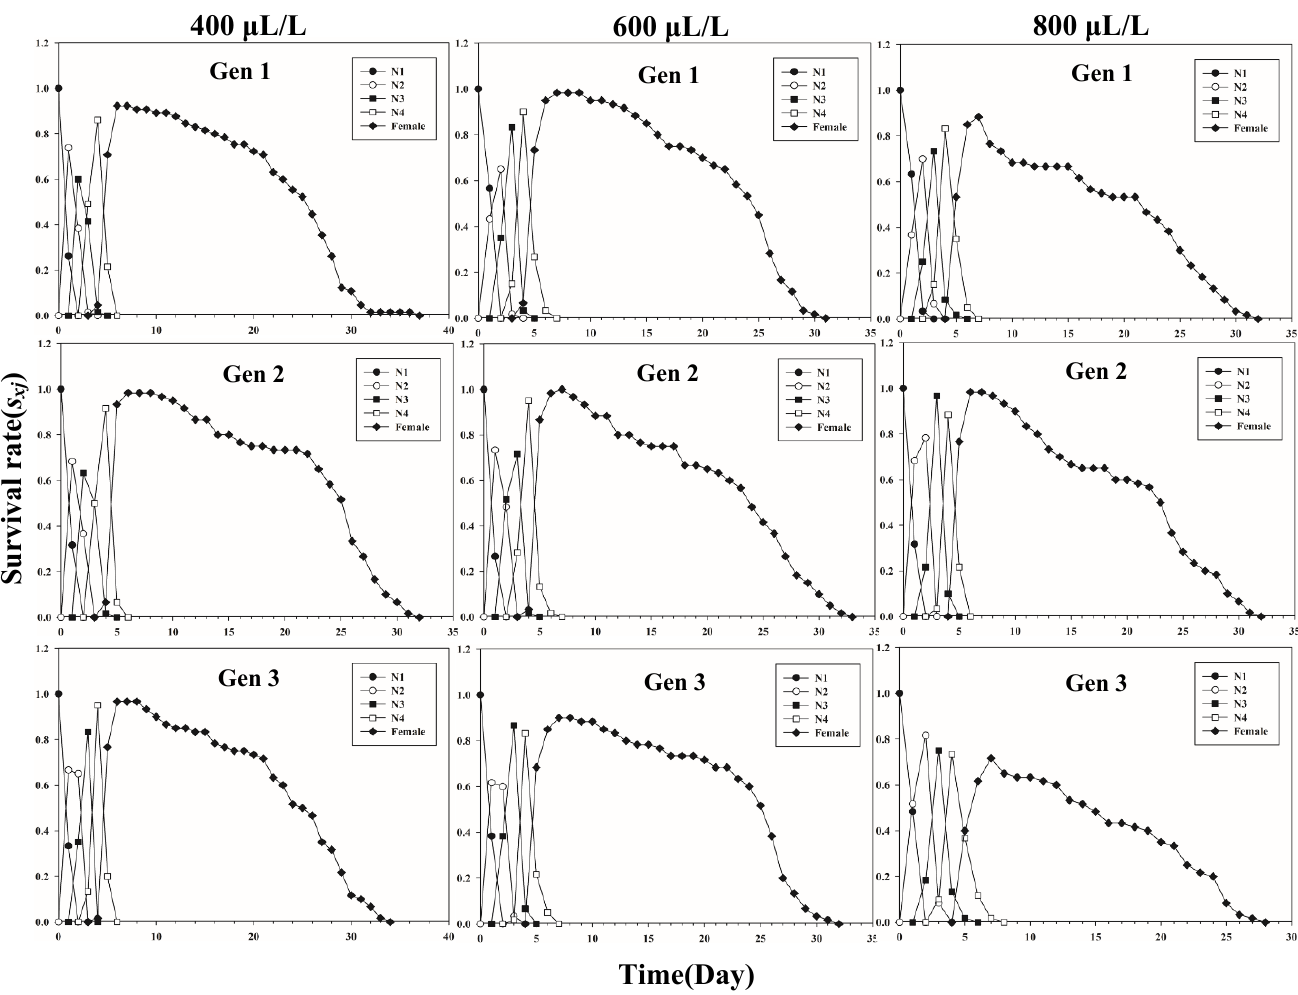
Figure 1. Age-stage-specific survival rates ( s xj ) of three successive generations of L. erysimi under three CO 2 treatments.